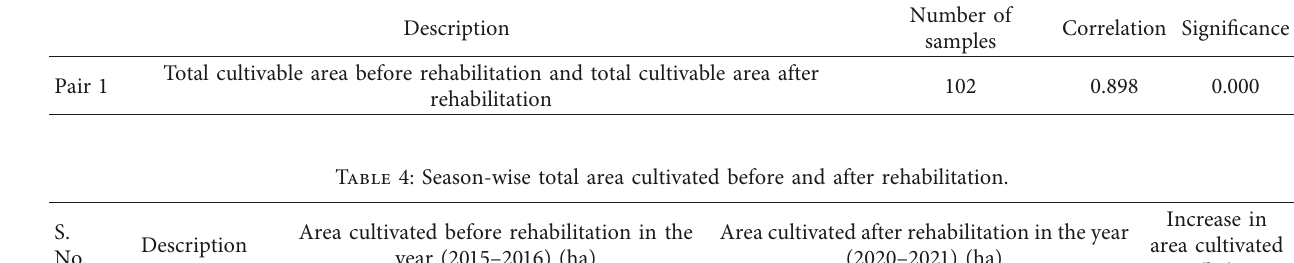
Table 3: Paired samples correlations for total area cultivated before and after rehabilitation.